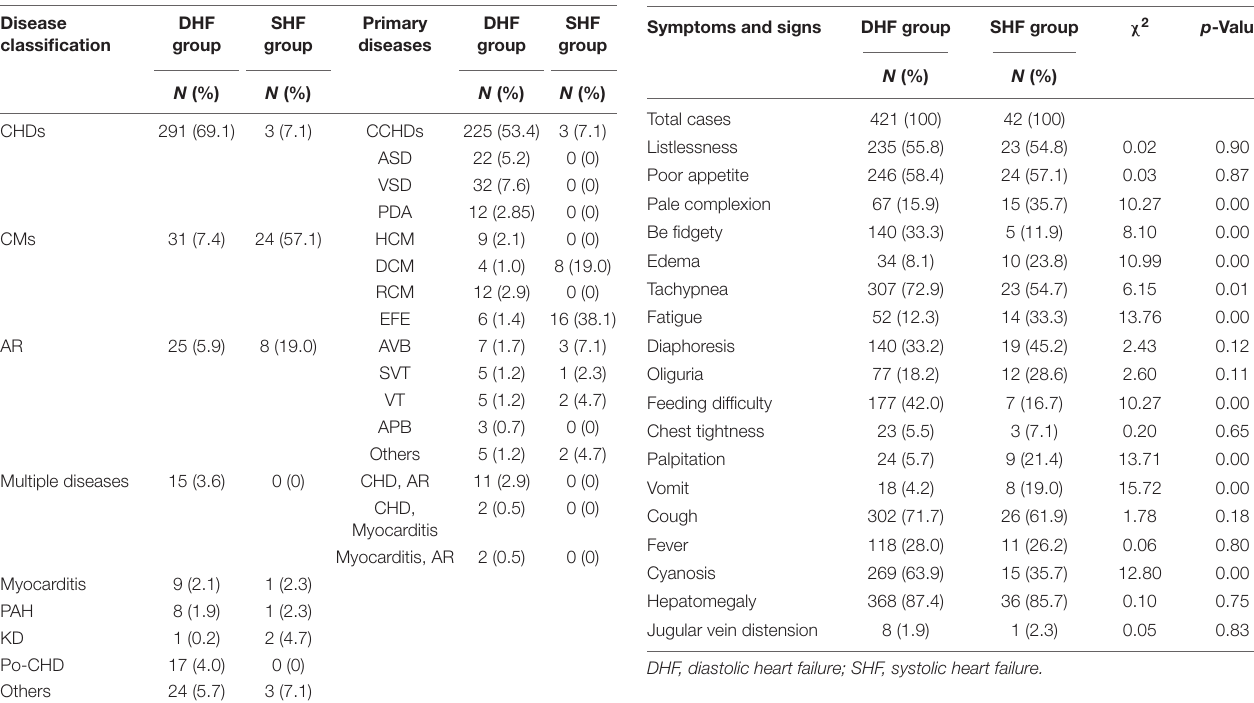
TABLE 3 | Symptoms and signs of DHF and SHF in